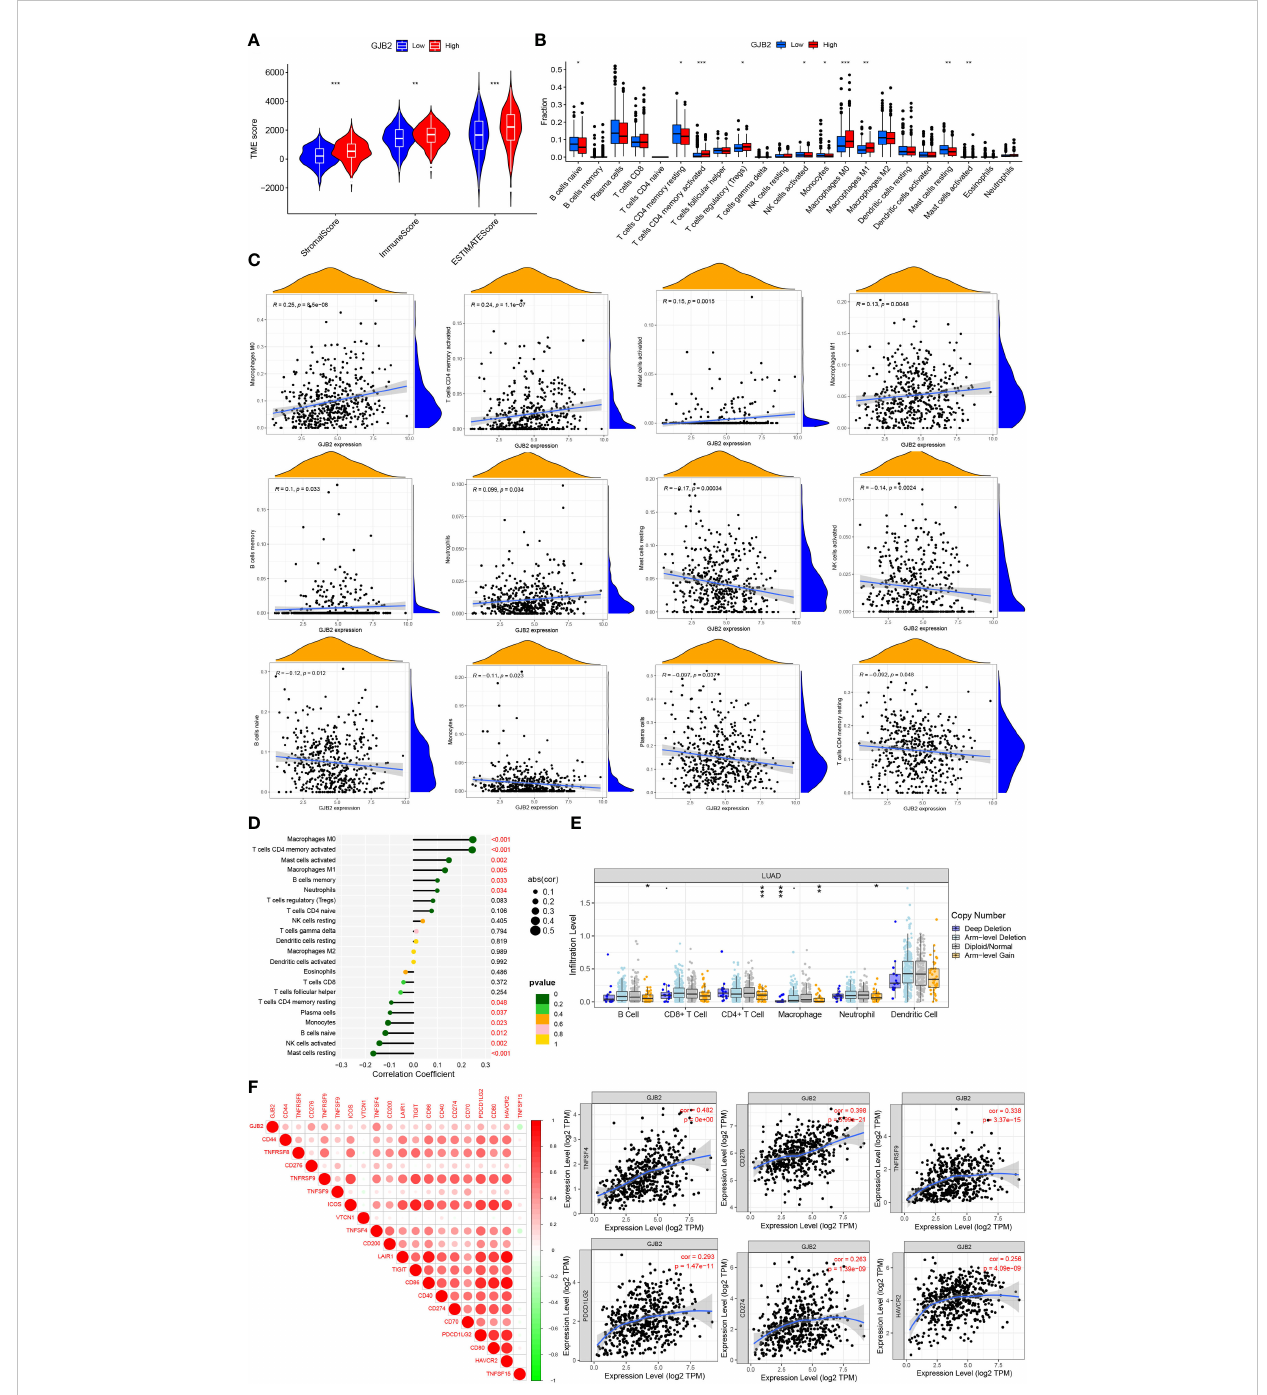
FIGURE 7 (A) Immune-score difference between GJB2 high-expression group and low-expression group. (B) Changes of 22 immune cell subtypes between high and low GJB2 expression groups in LUAD tumor samples. (C, D) Correlation between GJB2 and immune in fi ltrating cells in LUAD. (E) GJB2 CNV affects the in fi ltrating levels of B cells, CD4+ T cells, macrophages, and neotrophils in LUAD. (F) Correlations between GJB2 and various immune checkpoints. *P<0.05, **P<0.01,